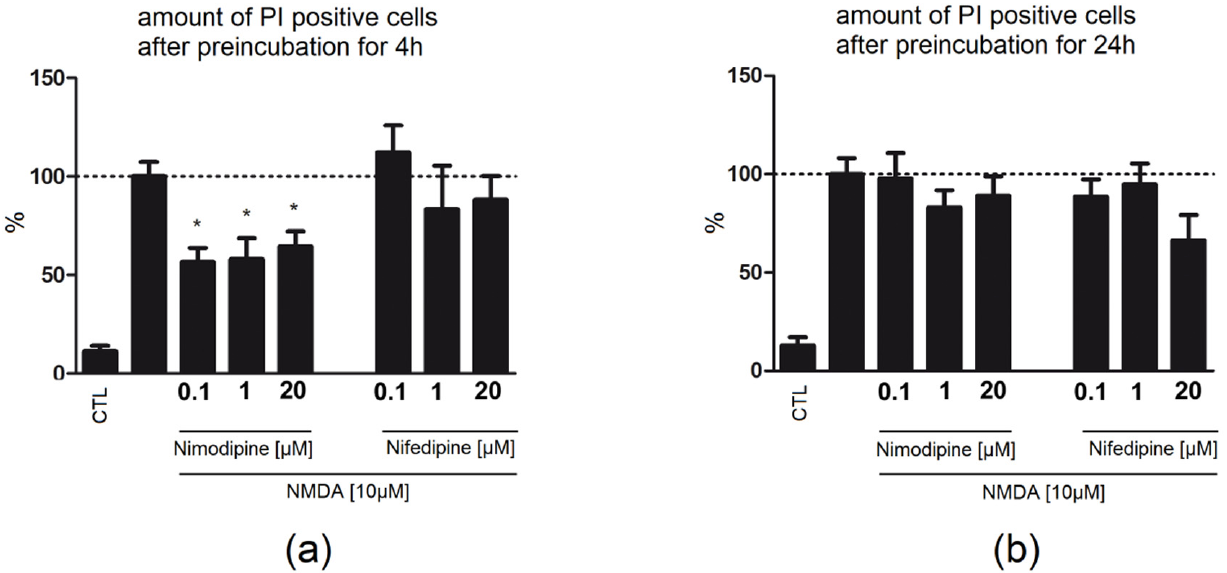
Figure 3. Effect of nimodipine and nifedipine in NMDA-damaged OHSC at different time points of application. Only few cells were positive in the control group (( a ) n CTL = 18; ( b ) n CTL = 17). Application of NMDA (( a ) n NMDA = 28; ( b ) n NMDA = 27) for 4 h led to accumulation of PI-positive nuclei in the dentate gyrus. ( a ) Preincubation (4 h) with nimodipine (n 0.1 µ M = 8; n 1 µ M = 11; n 20 µ M = 9) led to significant reduction in the number of damaged neurons in comparison to nifedipine treatment (n 0.1 µ M = 9; n 1 µ M = 9; n 20 µ M = 10) that showed no reduction ( b ) Nimodipine (n 0.1 µ M = 19; n 1 µ M = 16; n 20 µ M = 13) or nifedipine (n 0.1 µ M = 18; n 1 µ M = 12; n 20 µ M = 5), when pre-applied for 24 h before NMDA-damaged OHSC had no significant effect on the number of PI-positive damaged cells. All values were normalized to NMDA. Data are presented as mean with SEM. * depict statistically significant results with p <